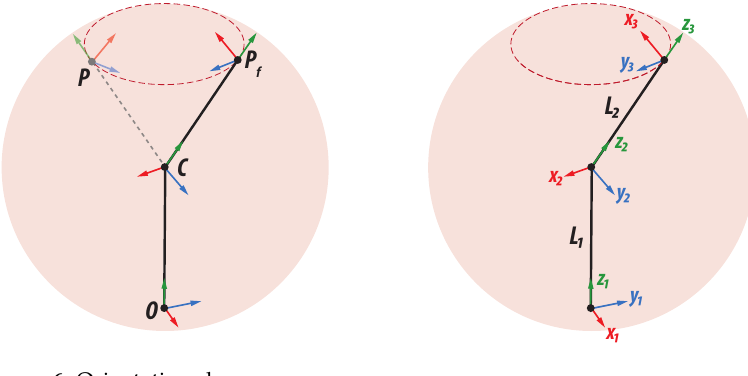
Figure 6. Orientation